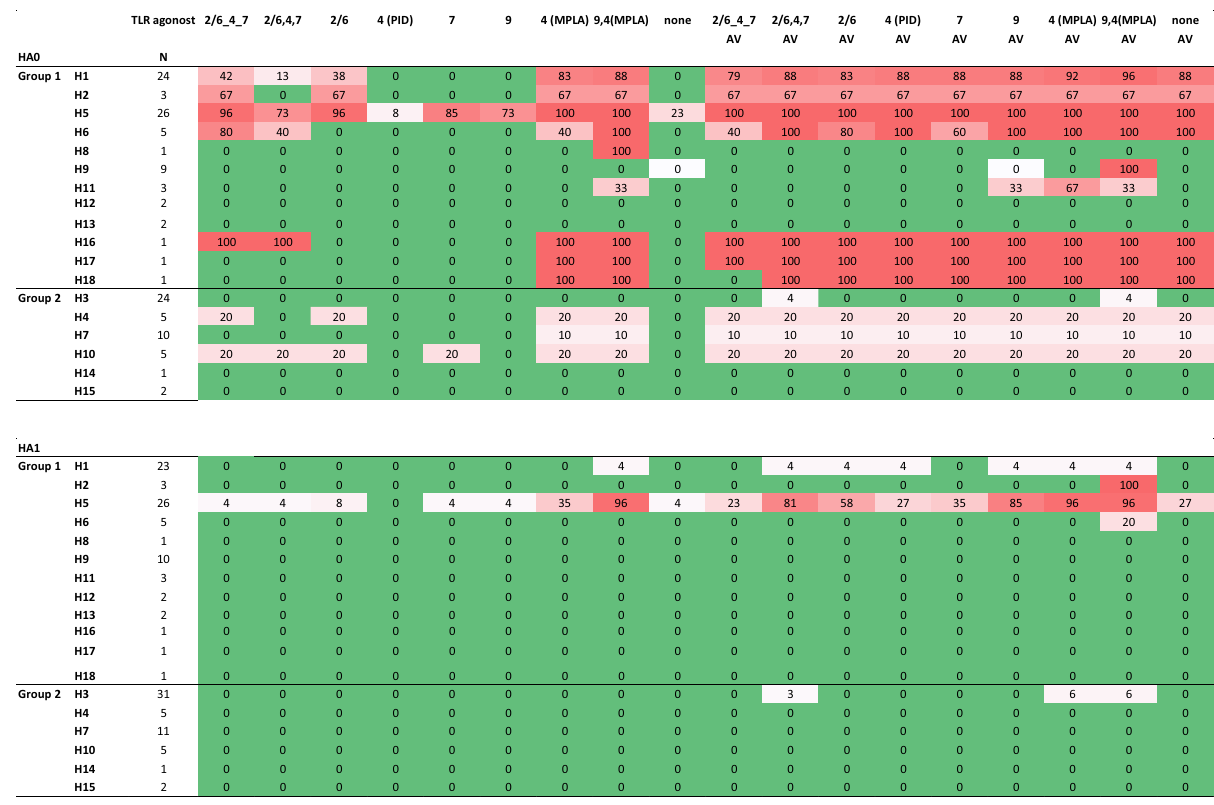
Table 2. Summary of breadth of response elicited by H5 administered in different adjuvants. Values are percentages of seropositive variants within each HA subtype printed on the array (both full-length HA0 and HA1 fragment) using data shown in Figs. 1 and 2. HA subtypes are organized into phylogenetic group 1 or 2. The cutoff for seropositivity was defined for each formulation with Log2 transformed data using the mean + 2SD of an irrelevant antigen, neuraminidase. N number of variants in each subtype on the array, AV AddaVax, other abbreviations as per Fig.